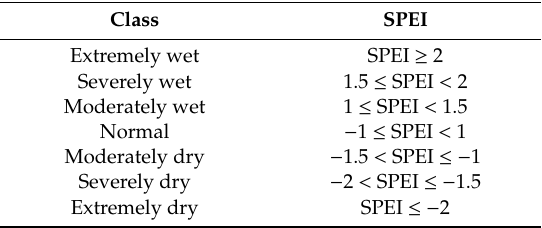
Table 2. Classification of SPEI values